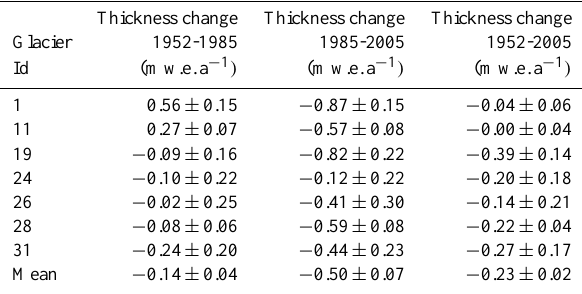
Table 6. Average annual thickness change in meters of water equiv-